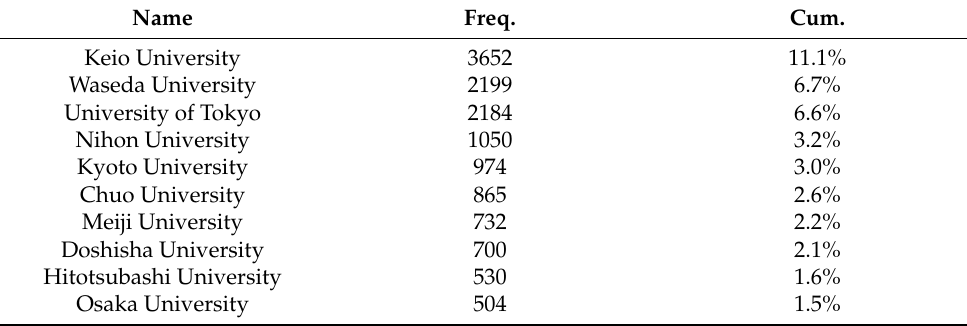
Table A2. The ranking for CEO producing universities in